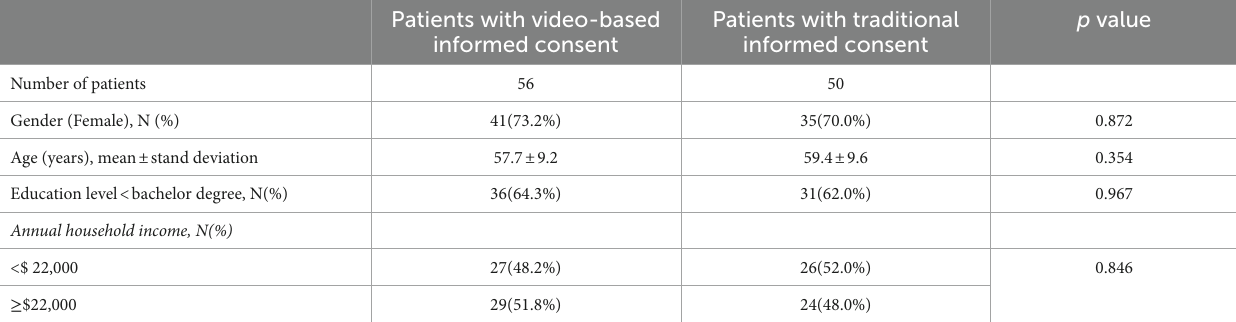
TABLE 2 Demographics of study patients.